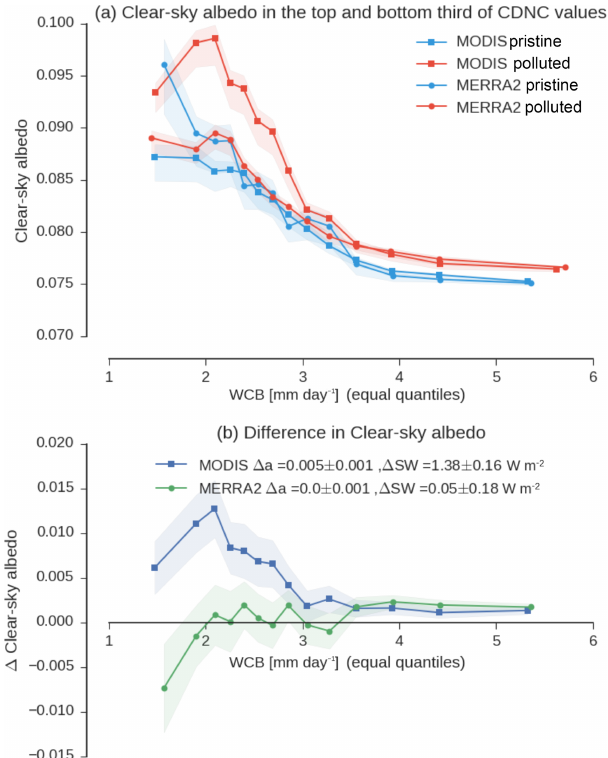
Figure 14. As in Fig. 13, but showing differences in cyclone-mean clear-sky albedo. The estimated difference in clear-sky SW is cal- culated based on the annual-mean insolation between 30 and 80 ◦ . Figure 15. The cyclone-mean CLWP in units of gm − 2 of liquid wa- ter observed by MAC-LWP binned as a function of WCB moisture flux and the CDNC SW retrieved by MODIS. Data are binned into equal size bins for the purpose of visualizing the data record. White lines show contours of constant CLWP as predicted by Eq. (1) and the coefficients listed in Table 2. The dependence of CLWP on CDNC SW inferred from MERRA2 is shown in Fig.